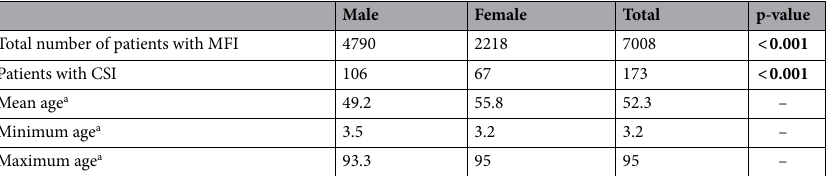
Table 1. Demographics of the study population. a Refers to age data in the patient group with concomitant CSI. p-values represent the p-values of χ 2 -test analyzing the difference between the two genders (confidence interval: p =